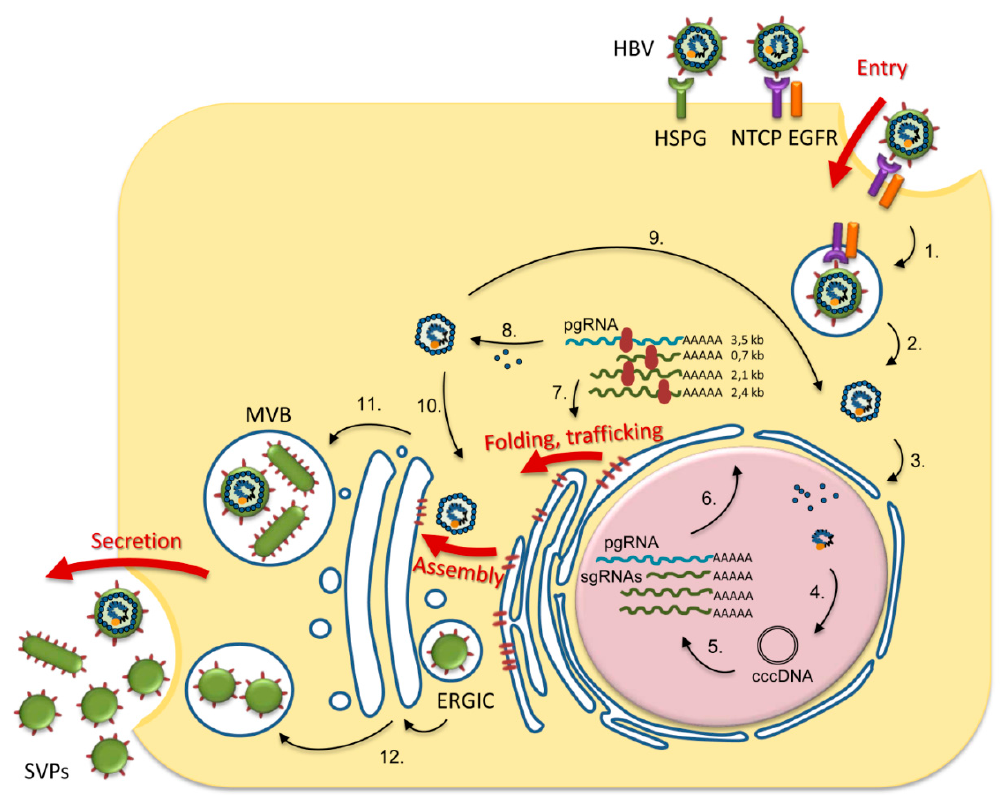
Figure 3. Overview of N-glycosylation roles in the HBV lifecycle. HBV entry begins with virion attachment to heparan sulfate proteoglycan (HPSG) followed by specific interaction with sodium taurocholate cotransporting polypeptide (NTCP)–epidermal growth factor receptor (EGFR) complex on the hepatocyte membrane, leading to endocytosis (1.). The HBV nucleocapsid is released from the endosomes (2.) and further transported to the nucleus (3.), where the viral genome is repaired by cellular enzymes to form covalently closed circular (ccc) DNA (4.). cccDNA is the template for transcription of pregenomic (pg) and subgenomic (sg) RNAs (5.), which are transported to the cytosol (6.). The viral proteins (polymerase, core, HBe, HBx, S, M, L) are synthesized from pg and